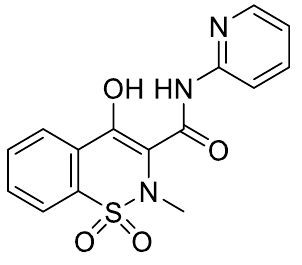
Figure 1. Structure of piroxicam.